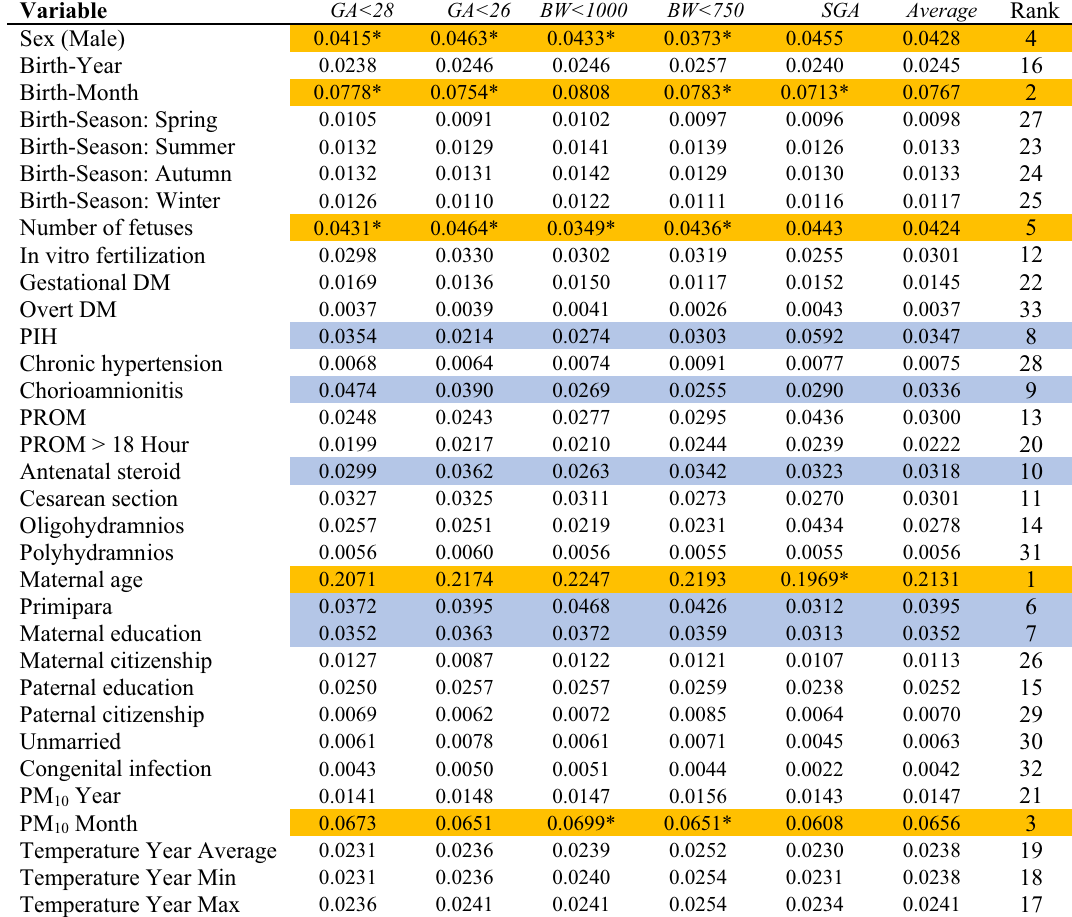
Table 5. Random forest variable importance for adverse birth outcomes: PM 10 included. The ranking of a top-5 predictor was highlighted with the color of orange and 6–10 predictor was highlighted with the color of mild blue. BW, birth weight (grams); DM, diabetes mellitus; GA, gestational age (weeks); PIH, pregnancy-induced hypertension; PM, particulate matter; PROM, prelabor rupture of membranes; SGA, small-for-gestational age. * P < 0.10 chi-square or T test (Table